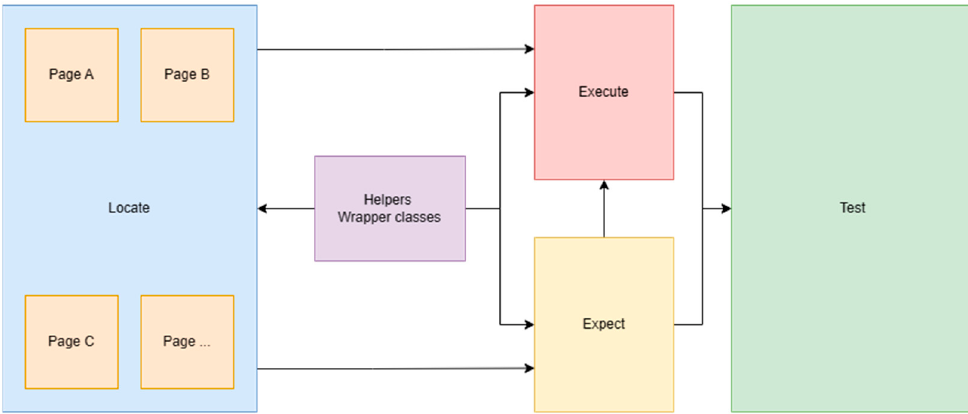
Figure 10. LEE design pattern diagram.